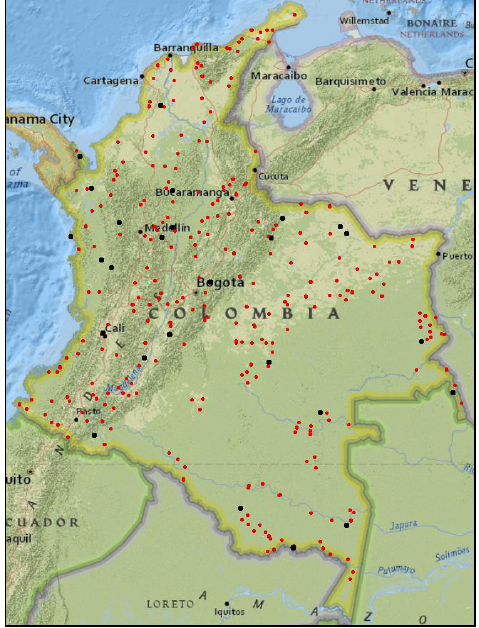
Figure 1. Location of plots (red dots) and PPMs (black squares) A NFI plot is composed of five 30 m diameter circular subplots (SPFs) (Figure 2). Thus, each plot consists of 0.35 ha of actual measurements (0.07 ha per SPF). The dimensions of the PPMs are 100m x 100m and usually share the central coordinates with the centre of the central SPF (SPF-1) within an existing plot (Figure 2). Additionally, the SPF follow a concentric nested sampling for different diameter classes (Figure 2).